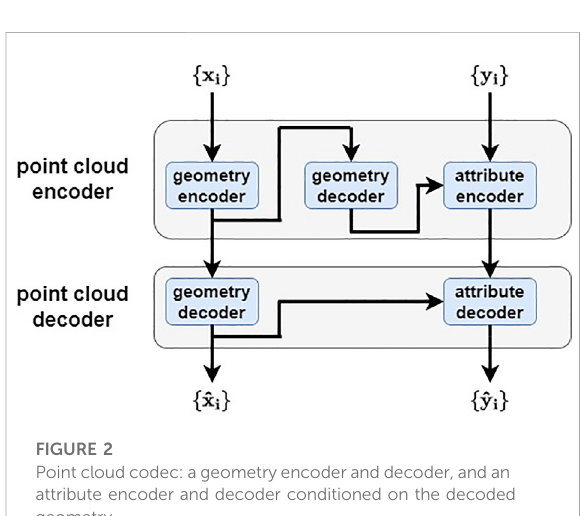
FIGURE 2 Point cloud codec: a geometry encoder and decoder, and an attribute encoder and decoder conditioned on the decoded